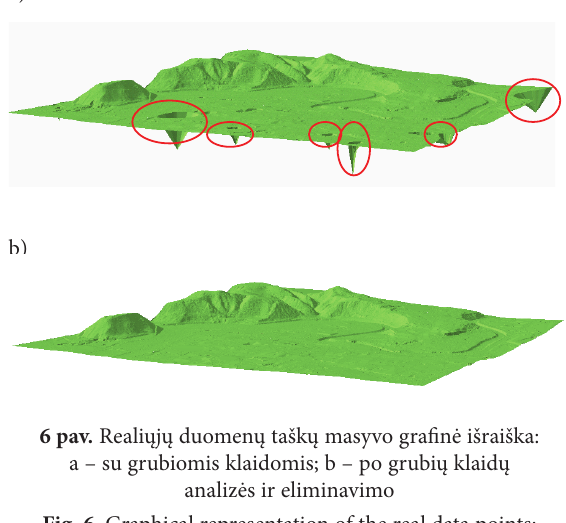
Fig. 6 . Graphical representation of the real data points: a – with gross errors; b – after analysis and